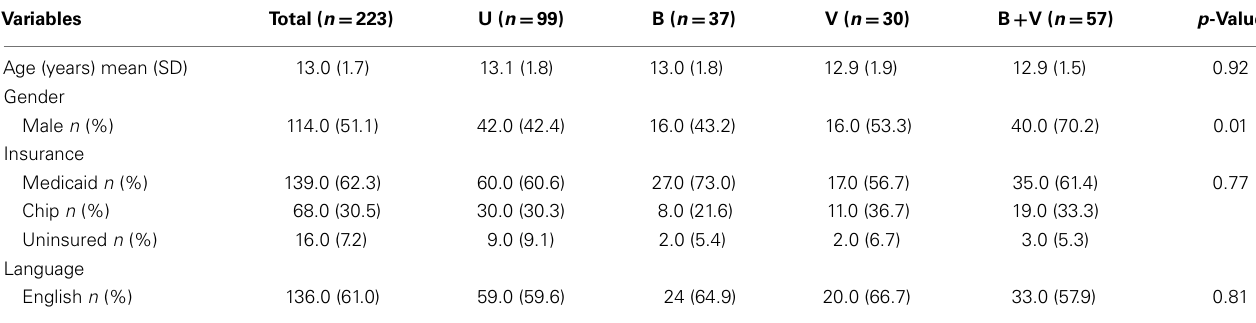
Table 1 | Comparison of socio-demographic characteristics of study subjects.